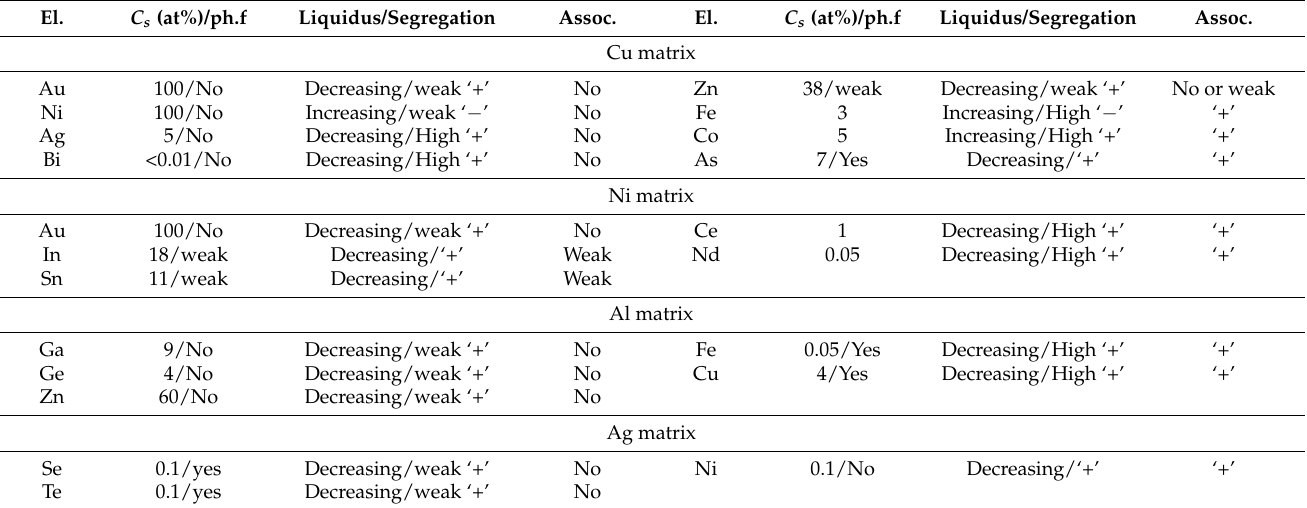
Table 1. Description of interaction between elements and between GB and diffusing elements (El. is name of element, C s is maximal solubility, ph.f is tendency to phase formation, assoc. is tendency toward atomic complex formation; negative or positive segregation is denoted by ‘ − ’ or